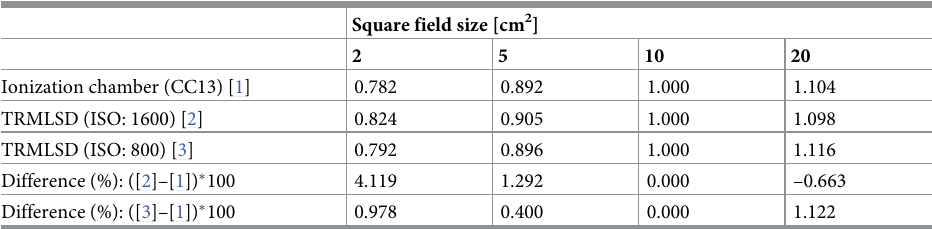
Table 1. Output factor of an ionization chamber and TRMLSD for two ISO values.